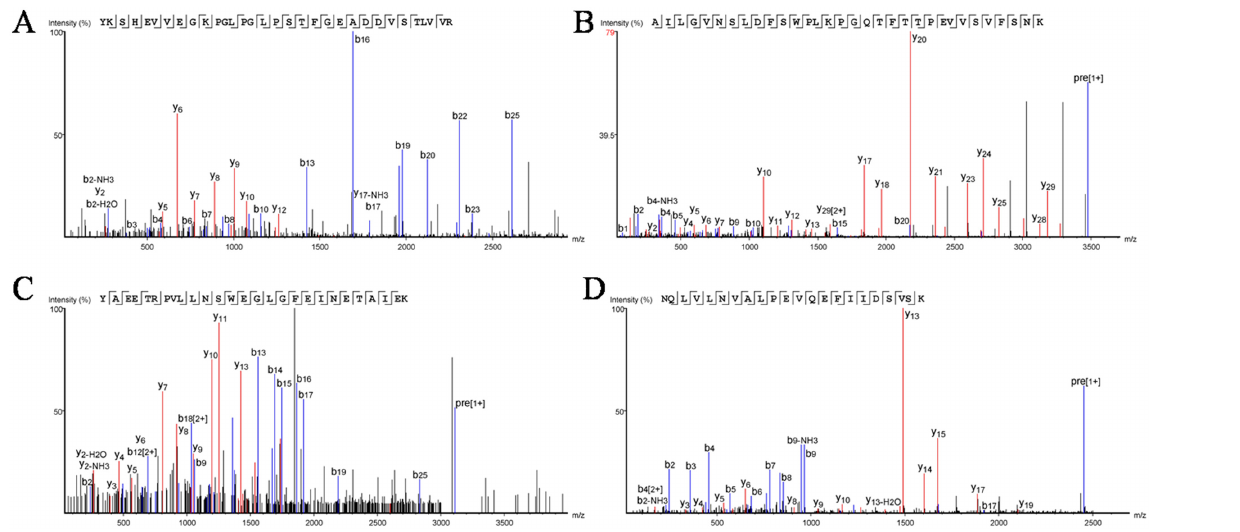
Fig 5. Peptides of Aga-F75M identified by MALDI-TOF mass spectrometry.